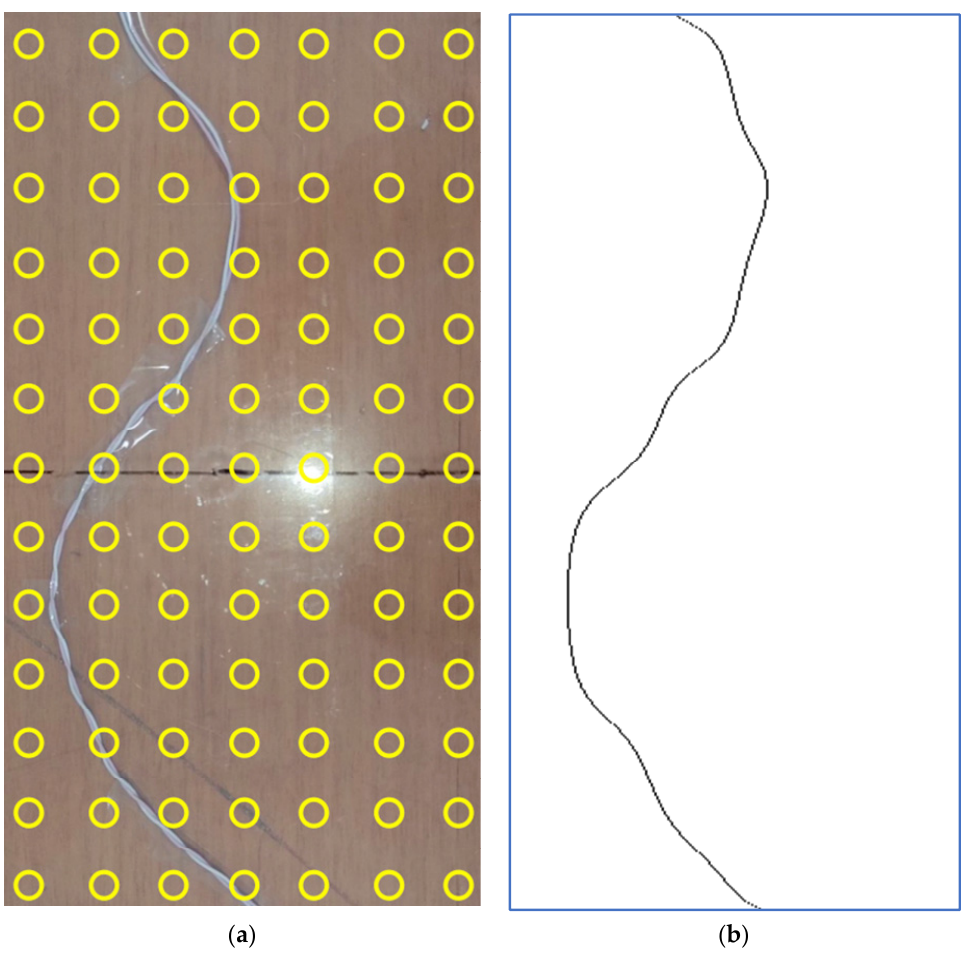
Figure 8. ( a ) Picture of the copper wire; ( b ) Estimation of copper wire